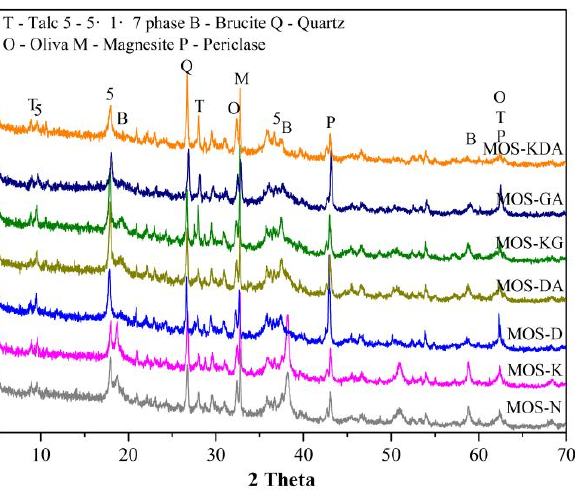
Figure 4. The XRD curves of magnesium oxysulfate cement-boron mud blends after air solidificating for 28 days adding different modifiers.